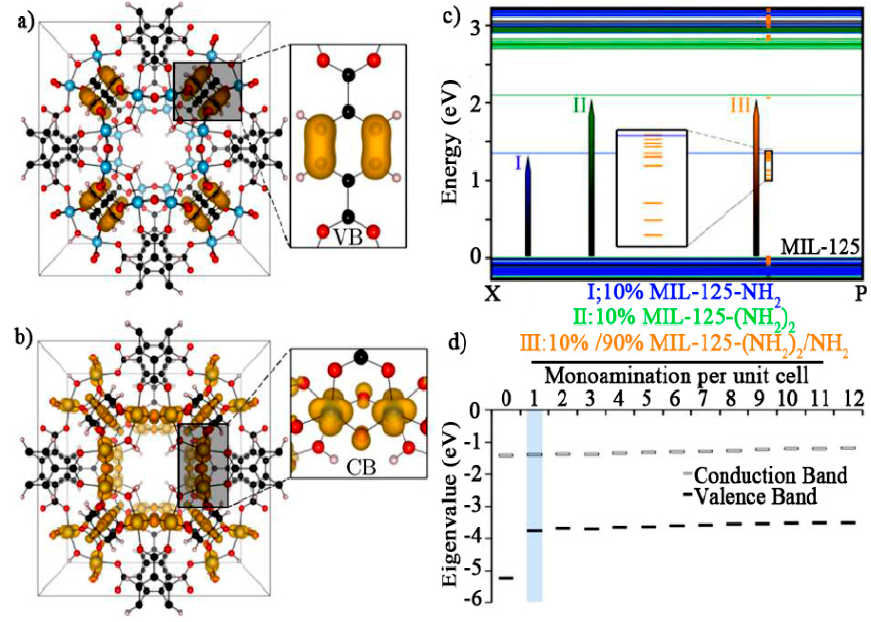
Figure 1. ( a ) the valence band is composed of the bdc C 2p orbitals (shown on the right), making these favorable for linker-based band gap modifications; ( b ) the conduction band is composed ofO 2p orbitals and Ti 3d orbitals (shown on the right). ( c ) PBEsol band structures for synthetic MIL-125 (black), 10%-MIL-125-NH2 (blue), 10%-MIL-125-(NH2)2 / 90%-MIL-125-NH2 (orange) and the theoretical 10%-MIL-125-(NH2)2 (green). ( d ) HSE06-calculated VB and CB energies of MIL-125-NH2 models containing increasing numbers of bdc-NH2 linkers [i.e. 0 (MIL-125) to 12 (100%-MIL-125-NH2)] per unit cell. MOFs materials for photocatalytic CO 2 reduction. Reprinted from ref. 74 with permission by the American Chemical Society.